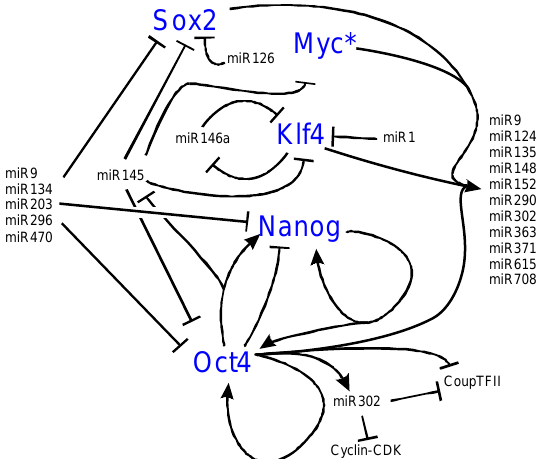
Figure 6. Oct4 , Sox2 , Klf4 and Myc are capable of reprogramming of mouse embryonic fibroblasts into pluripotent stem